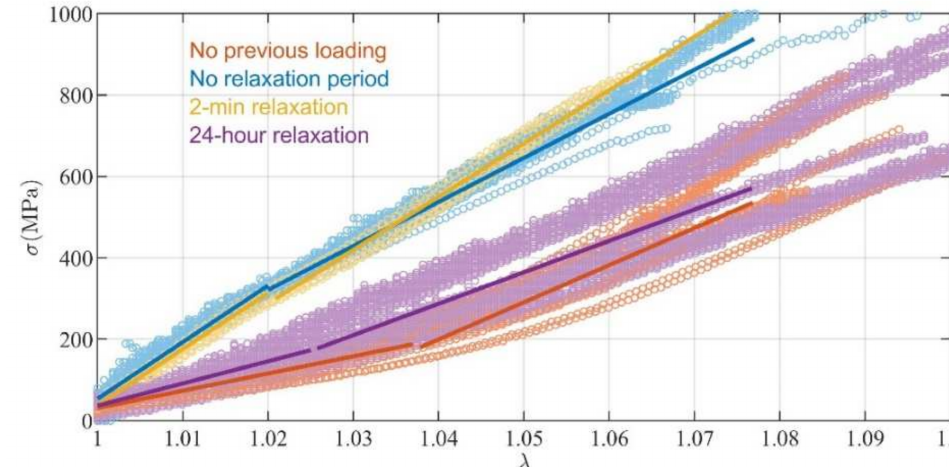
Figure 4. The experimental data of the load-to-failure tests performed without prior cyclic loading; immediately after 10 cycles of loading at 1–50 N; after a relaxation period of 2 min after cyclic loading; and after a relaxation period of 24 h after cyclic loading. Markers indicate the experimental data. Continuous lines are the fitted bilinear